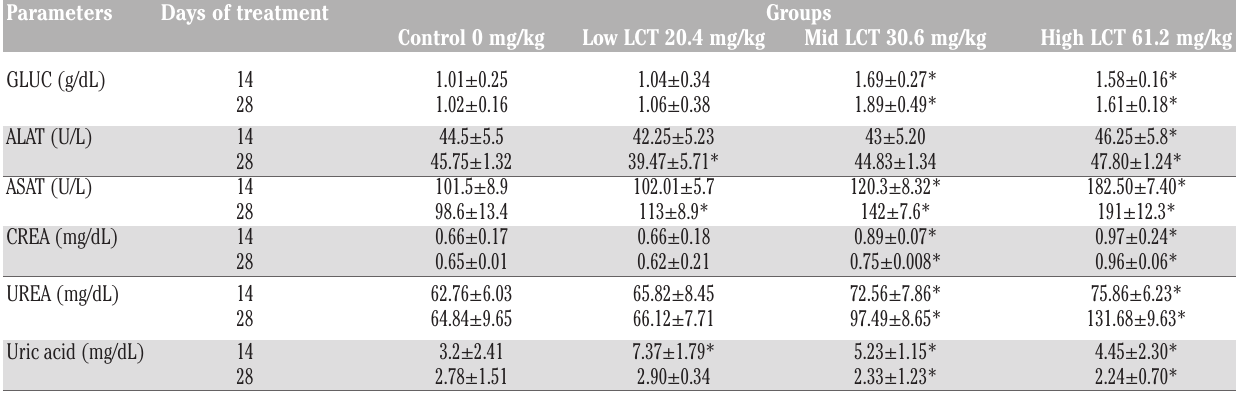
Table 2. Effects of lambda-cyhalothrin on biochemical parameters of blood chemistry in rat. Parameters